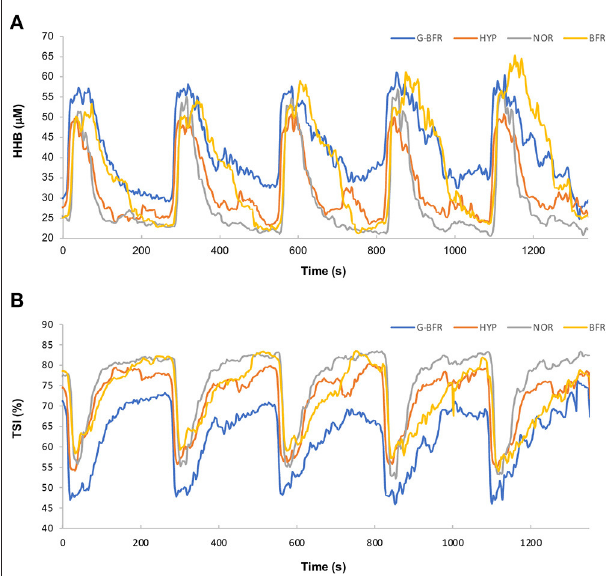
FIGURE 3 | Average deoxyhemoglobin (A) and tissue saturation index (B) . BFR 60 , blood flow restriction during the two first minutes of recovery; HYP, hypoxia in a chamber at 13.0% FiO 2 ; G-BFR, gravity-induced BFR; NOR,